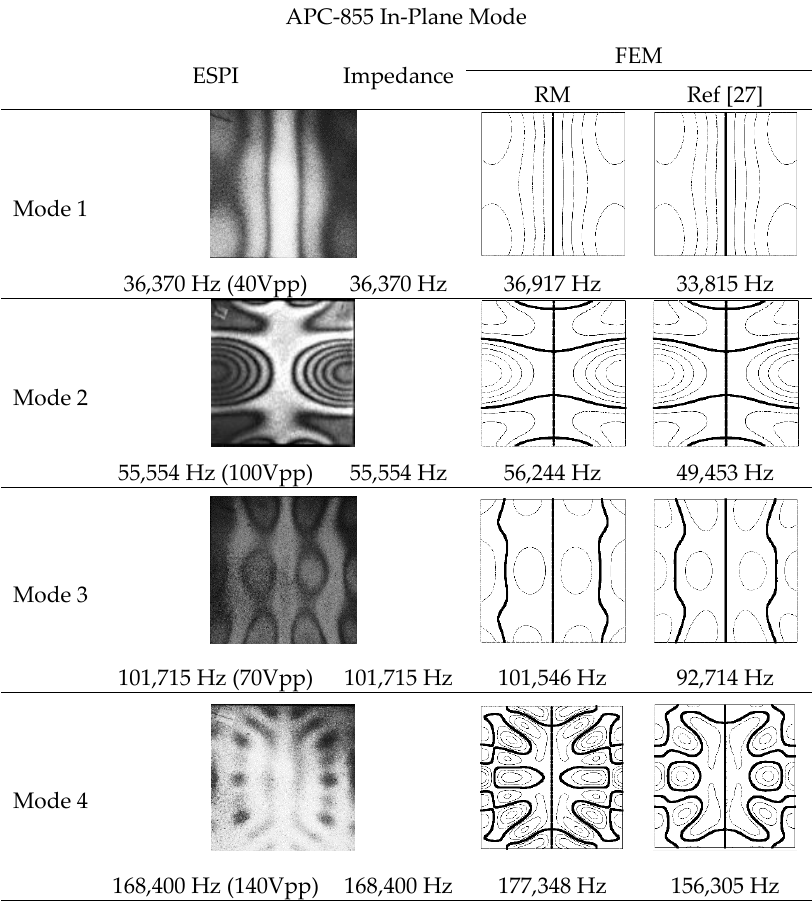
Figure 6. In-plane vibration mode for APC-855 before self heating in resonance.